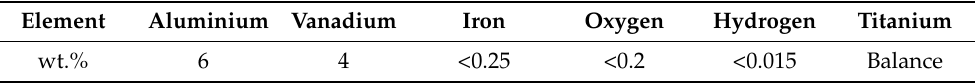
Table 3. Chemical composition of Ti6Al4V—Grade 5 alloy (wt.%).